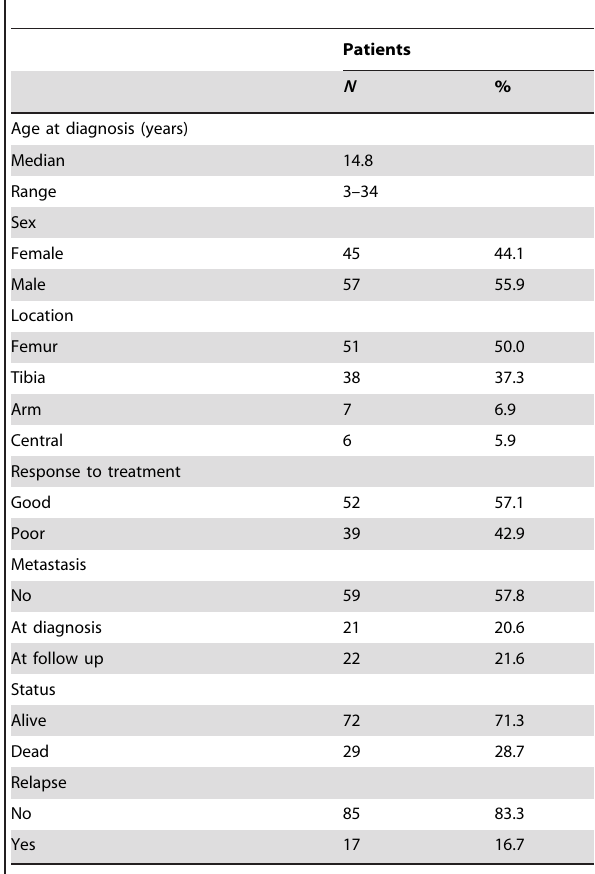
Table 1. Clinical characteristics of osteosarcoma patients ( N